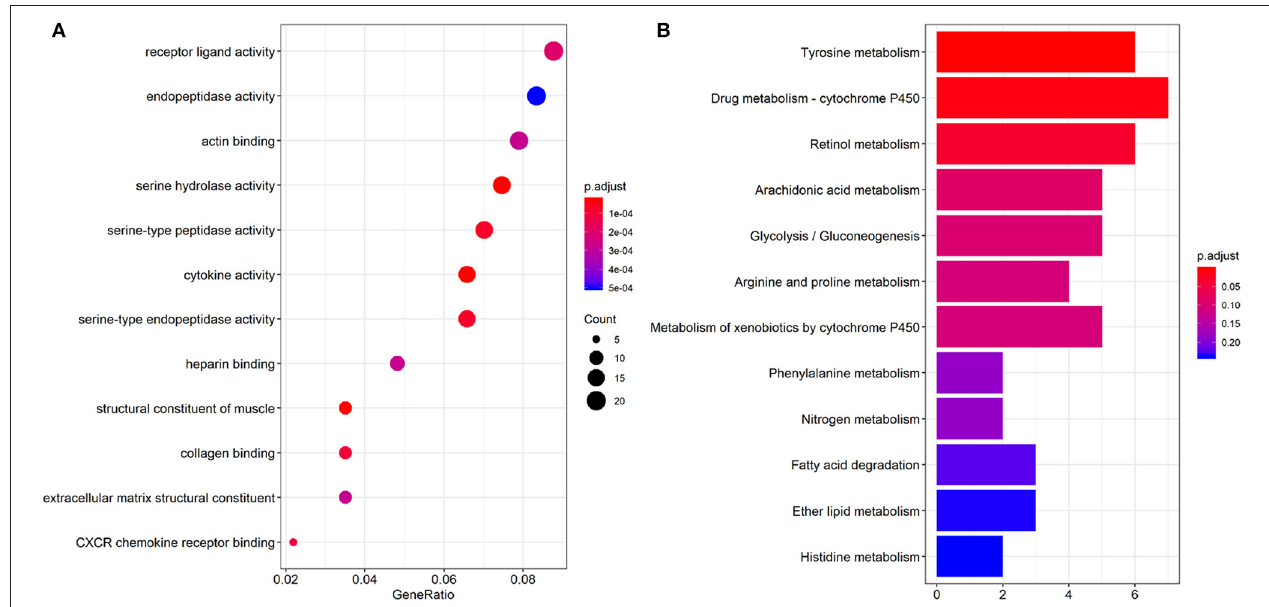
FIGURE 3 | Results of GO function (A) and KEGG pathway enrichment analyses (B)